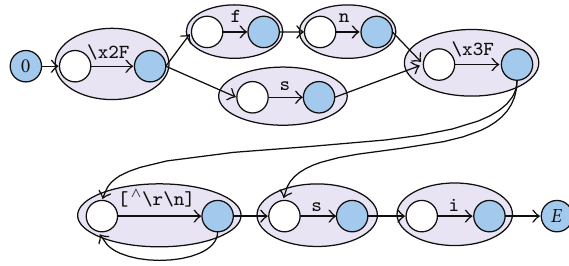
Figure 5: A modular NFA for “ \ x2F ( fn | s ) \ x3F [ (cid:2) \ r \ n ] ∗ si ” constructed using the MMY rules specified in Figure